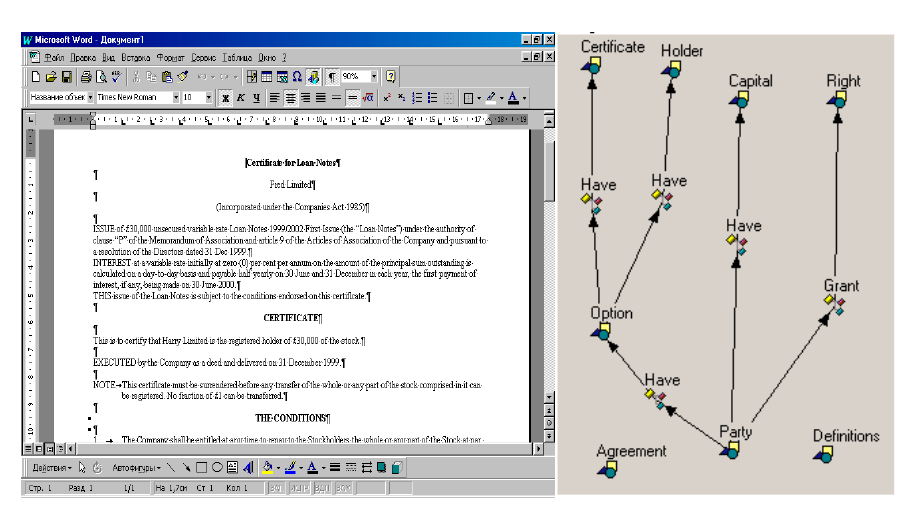
Figure 8. An example of a semantic descriptor for an insurance contract.